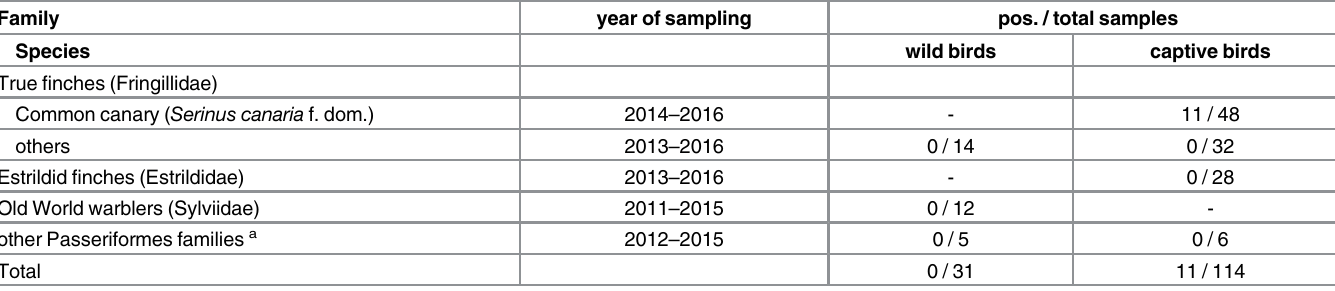
(S2 Fig). However, closely related or identical PaBV-2 sequences found in different species con-